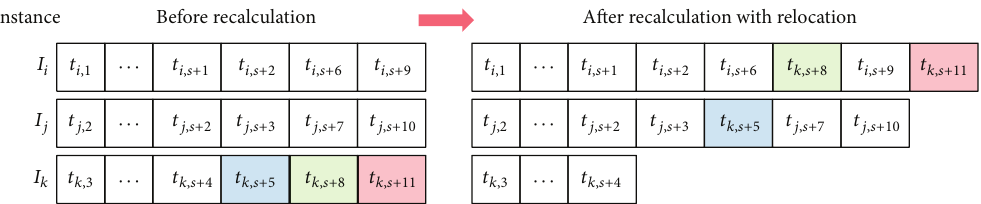
Figure 4: The recalculation operation of the assigned